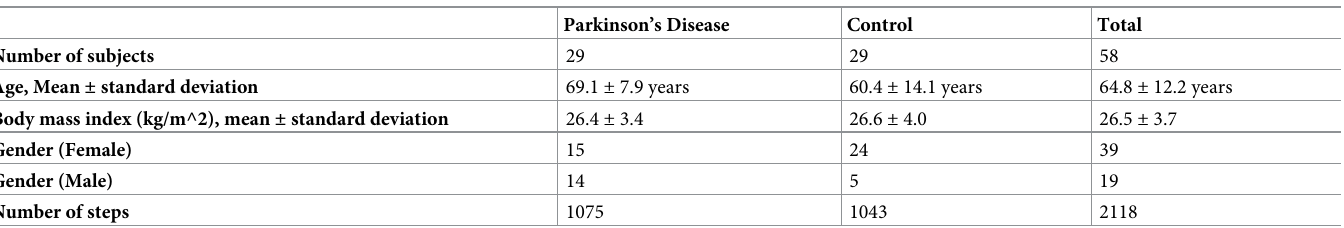
Table 1. Demographic data of cohort used in study.